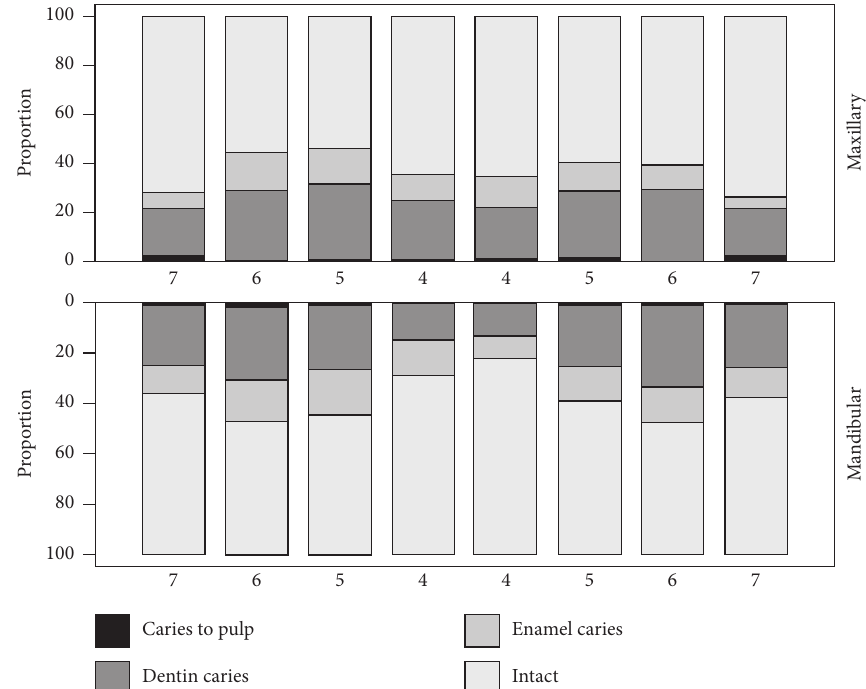
Figure 1: Distribution of caries lesions of different depth in maxillary and mandibular premolar and molar teeth.